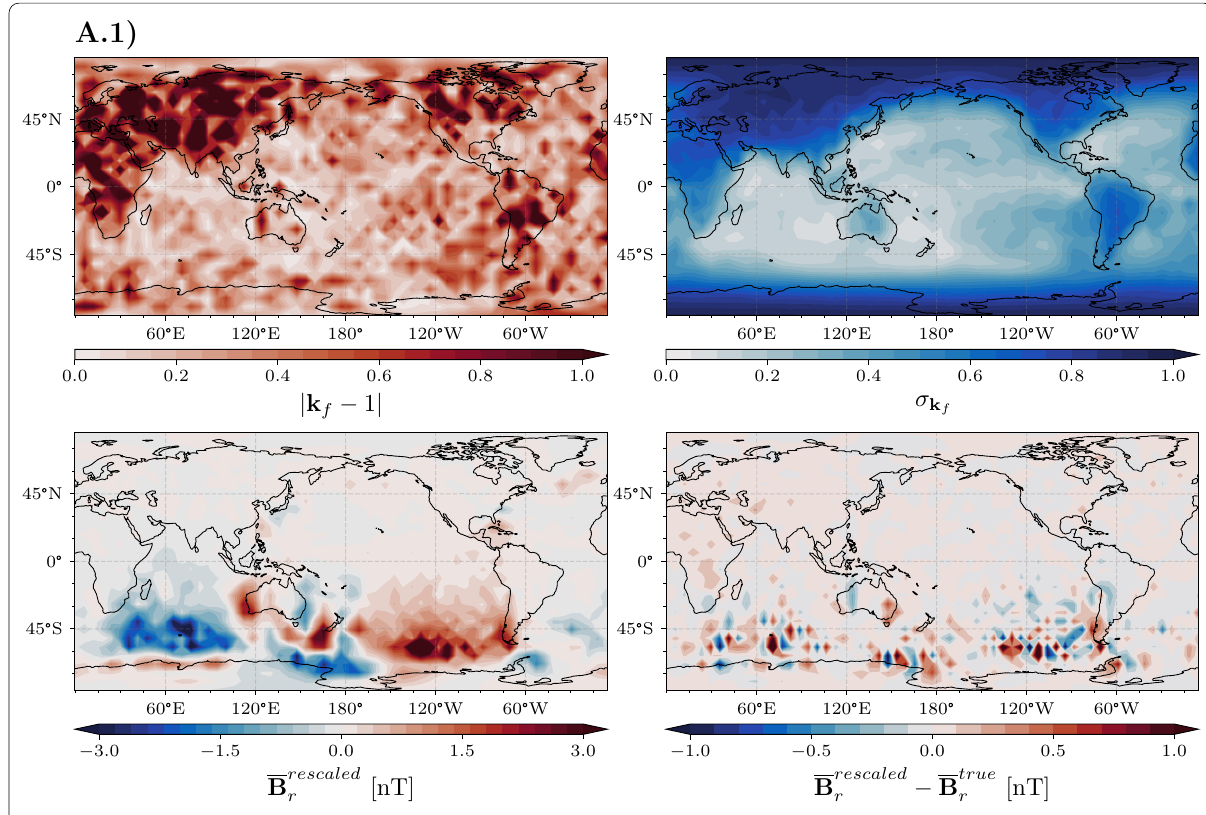
Fig. 4 The assimilation results for the ideal test case scenario with identical true and imposed magnetic fields. The upper plots show both the absolute deviation of the final scale factor k f from the true value of 1 (left) and the associated uncertainty (posterior standard deviation) of the final scale factor σ k f (right). Dark red (respectively, blue) indicates unchanged major deviations (respectively, posterior standard deviation) after the assimilation, whereas lighter colors point out areas with lower deviations and reduced uncertainty. The bottom plots present the results for rescaled the rescaled imposed field using the final scale factor. The radial component of the temporal averaged rescaled OIMF B r is shown on the left. true Its deviations from the temporal averaged true oceanic contribution B r included in the observations, are shown on the right. Here, red colors indicate higher and blue lower values in the radial component of rescaled OIMF than the true OIMF. Note the different color range to show the